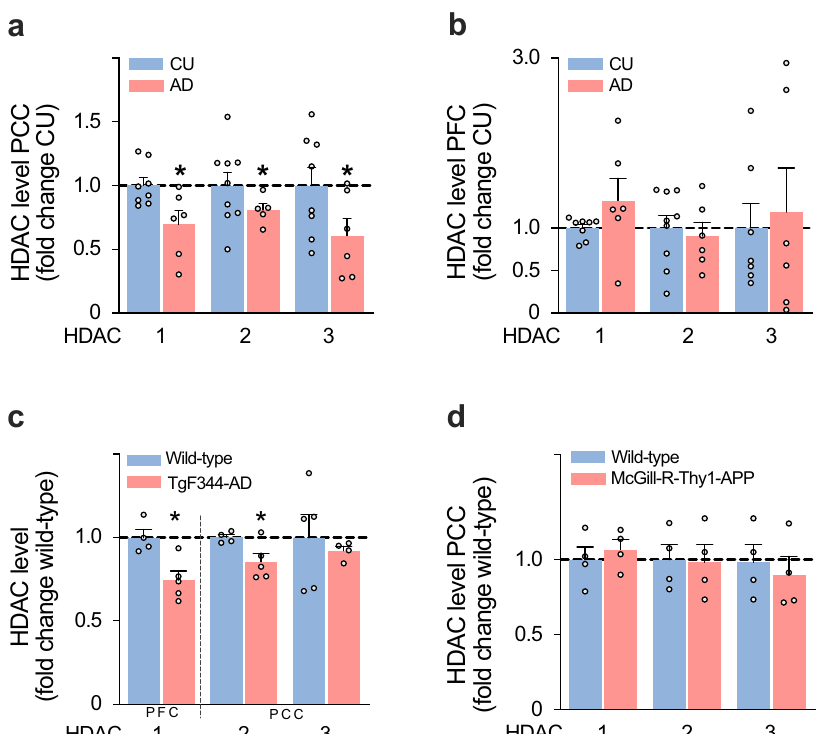
Fig. 6 Postmortem analysis shows HDAC I reduction within vulnerable brain regions in Alzheimer ’ s disease patients and rats overexpressing human amyloid- β and tau pathology. Quanti fi cation from brain lysate showed downregulation of HDAC1 ( P = 0.0364), HDAC2 ( P = 0.0186), HDAC3 ( P = 0. 0329) in a the posterior cingulate cortex (PCC) of patients with AD (CU, n = 9; AD, n = 6), whereas no signi fi cant difference was found in b the prefrontal cortex (PFC) (CU, n = 9; AD, n = 6) for HDAC1 ( P = 0.275), HDAC2 ( P = 0.5885), HDAC3 ( P = 0. 7346). c TgF344-AD rats ( n = 5 rats each group), which express human amyloid- β and tau pathology, showed a signi fi cant reduction in HDAC1 ( P = 0. 0093), HDAC2 ( P = 0.0446), and a trend in HDAC3 ( P = 0. 0613). d McGill-R-Thy1-APP rats ( n = 4 rats each group), which express human amyloid- β without developing tau pathology, showed normal HDAC1 ( P = 0. 3581), HDAC2 ( P = 0.8972), and HDAC3 ( P = 0. 4781) levels. *Indicates P < 0.05 (two-sided), one-sample t -test; values are mean ± standard error of the mean. HDAC1 – 3 levels were normalized to beta-actin as a loading control. Uncropped and unprocessed images of the Western Blots are provided as a Source Data sacri fi ced by decapitation while anesthetized; the brains were rapidly removed, frozen in liquid nitrogen-isopentanol solution, and stored at − 80 °C. The pre- frontal and posterior portion of the cingulate (retrosplenial) cortices were dissected and used in the analysis. Image methods . At the MCSA site, participants had 3T MRI (Siemens) and [ 11 C] Martinostat 24 , [ 18 F]MK-6240 38 , and [ 18 F]AZD4694 39 PET scans acquired with a Siemens high-resolution research tomograph. At the MGH site, MR and [ 11 C]Mar- tinostat images were simultaneously acquired on a 3T Siemens TIM Trio containing a BrainPET insert. [ 11 C]Martinostat SUVR for quantifying HDACs I (isoform 1 – 3) was measured using the telencephalon white matter as reference from 60 to 90min after tracer injection 24 . [ 18 F]MK-6240 SUVR for quantifying tau neuro fi brillary tanglesand [ 18 F]AZD4694SUVRforquantifyingamyloid- β usedthecerebellumgray matter as reference and were calculated at 90 – 110 and 40 – 70min after tracer injection, respectively 38,39 . PET images were spatially smoothed to achieve a fi nal 8-mm full width at half maximum resolution. Although both sites used brain- dedicated PET scanners with a high spatial resolution, which makes the images less susceptible to volume effects, we used only partial volume corrected data. Partial volume correction of PET images was performed using the region-based voxel-wise method 40 .Regions-of-interestweretailoredusingtheMNIICBMatlas.Brainatrophy was assessed with the analysis of gray matter density on T1-weighted images using voxel-based morphometry technique. Hippocampal volume was measured with Freesurfer version 6.0 using the Desikan – Killiany – Tourville gray matter parcellation in a structural T1-weight MRI 41 . For the subset of participants who had full dynamic [ 11 C]Martinostat acquisitions from 0 to 90min after intravenous tracer injection ( n = 48, CU young = 9, CU elderly = 15, MCI = 8, and AD = 16), we generated R1 relative tracer delivery parametric maps. For the R1 analysis, the dynamic PET data were binned with gradually increasing intervals into 26 frames (6×10s, 6×20s, 2×30s, 1×1min, 5×5min, 6×10min) and reconstructed in units of Becquerel per milliliter. The dynamic data were smoothed with a Gaussian kernel at 8mm full width at half maximum. To remove extracerebral noise potentially resulting from the